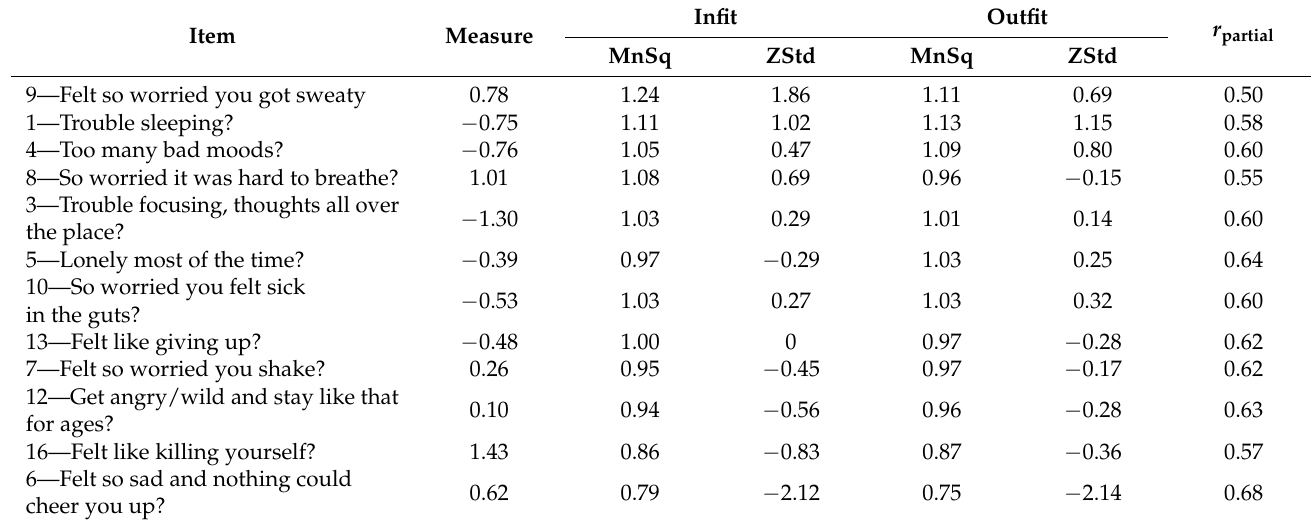
Table 2. Final 12 Distress item difficulties, fit, and measure correlations in order of descending misfit.